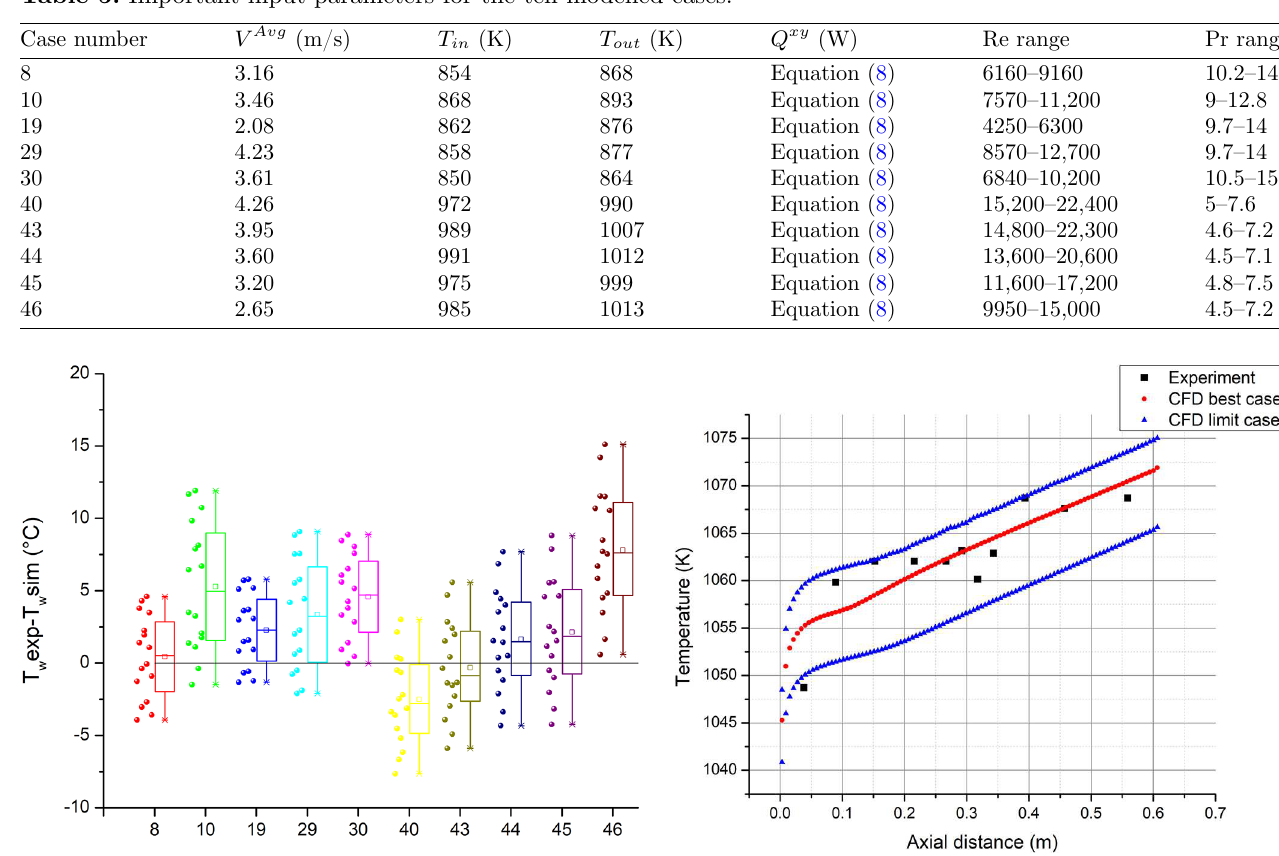
Table 5. Important input parameters for the ten modelled cases.